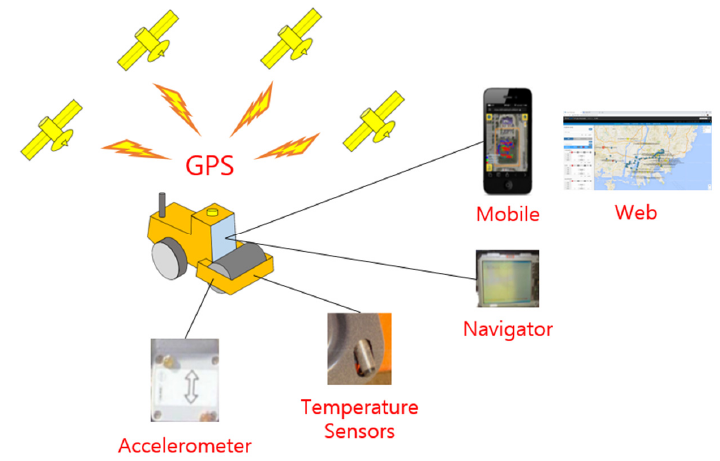
Figure 1. Major components of the IC roller.